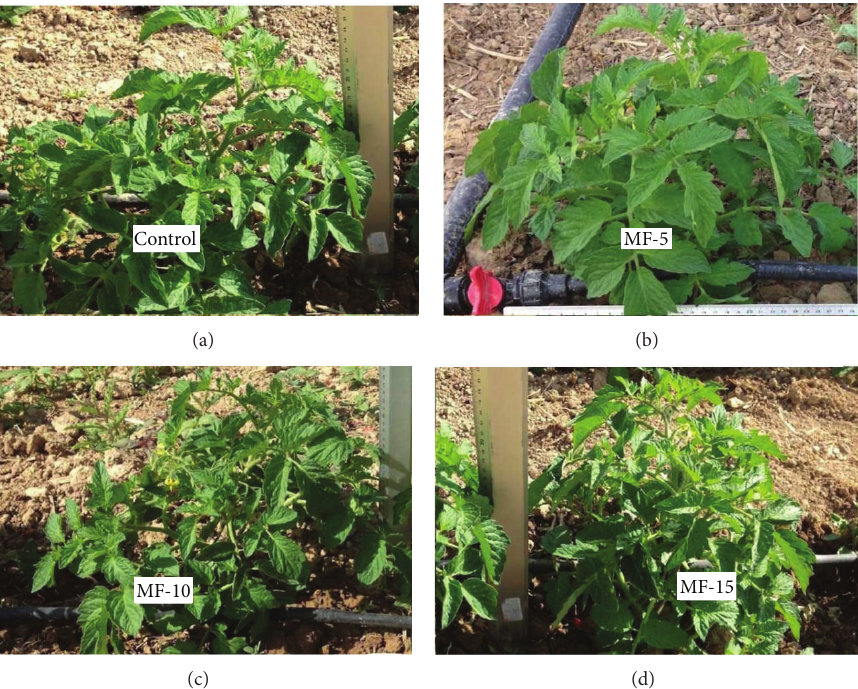
Figure 5: Showing the comparative effect of pulsed electromagnetic field treatment on the main agronomic plant characteristics. Control: untreated seeds; MF-5, MF-10, and MF-15: seeds treated with pulsed electromagnetic field for 5min, 10min, and 15min,